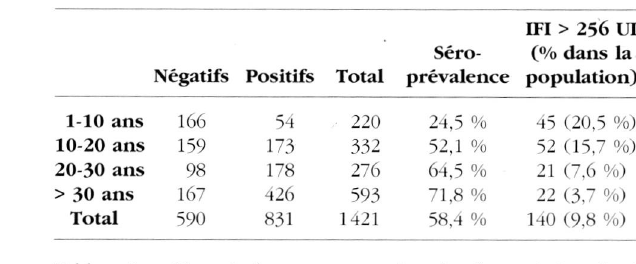
Tableau I. - Séroprévalence et proportion de sérums à titre élevé en fonction de l'âge dans la population d'étude.